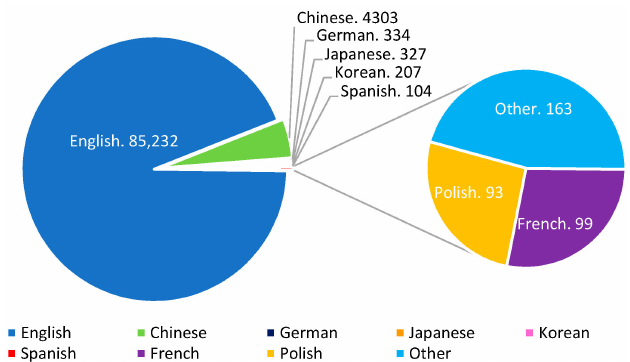
Figure 14. Representation of the languages of EV